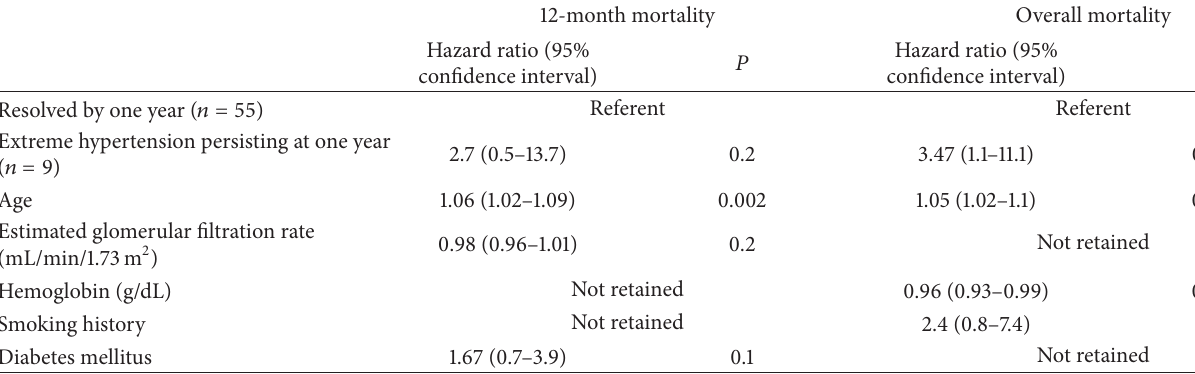
Table 3: Hazard ratio for death for patients with extreme hypertension at